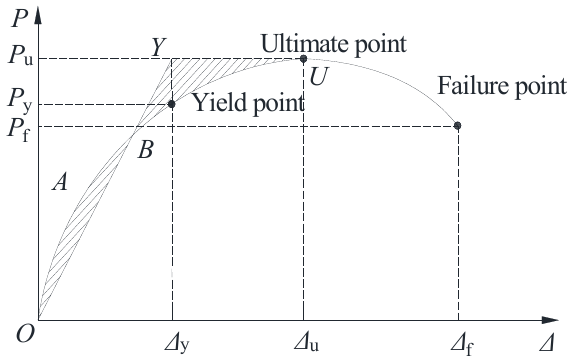
Figure 11. Characteristic points on the load–displacement curve. Table 5. The measured load and displacement at characteristic points.